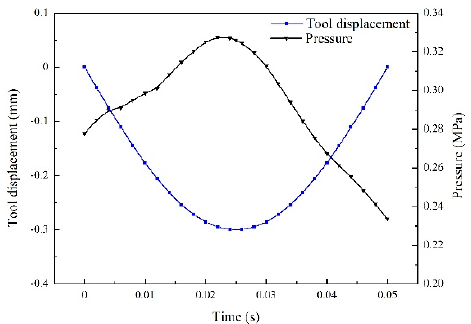
Figure 4. Average pressure in the inter-electrode gap and tool displacement as a function of time during one half-period of tool vibration.